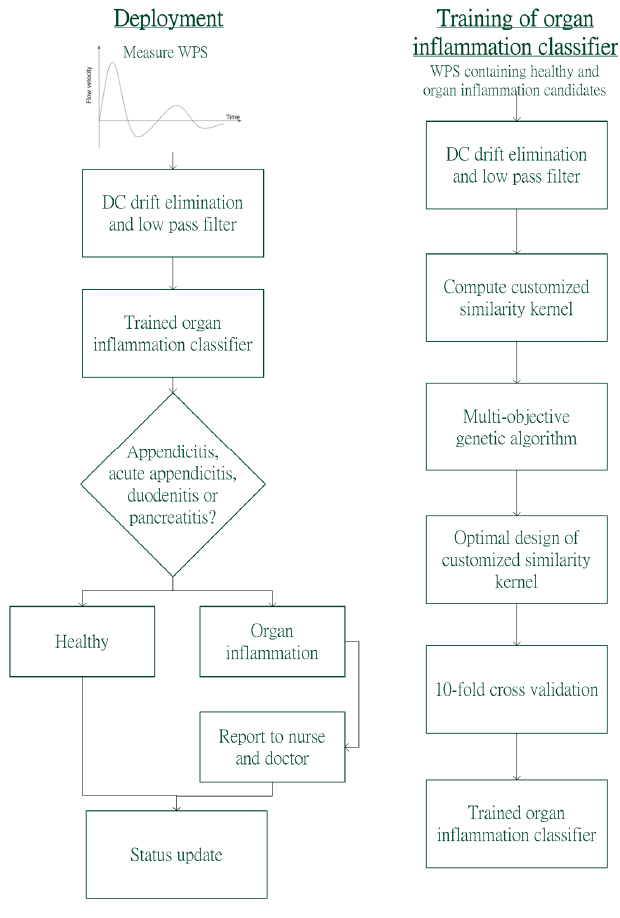
Figure 1. Overview of multi-objective genetic algorithm based support vector machine (MOGA-SVM) for organ inflammations classification.